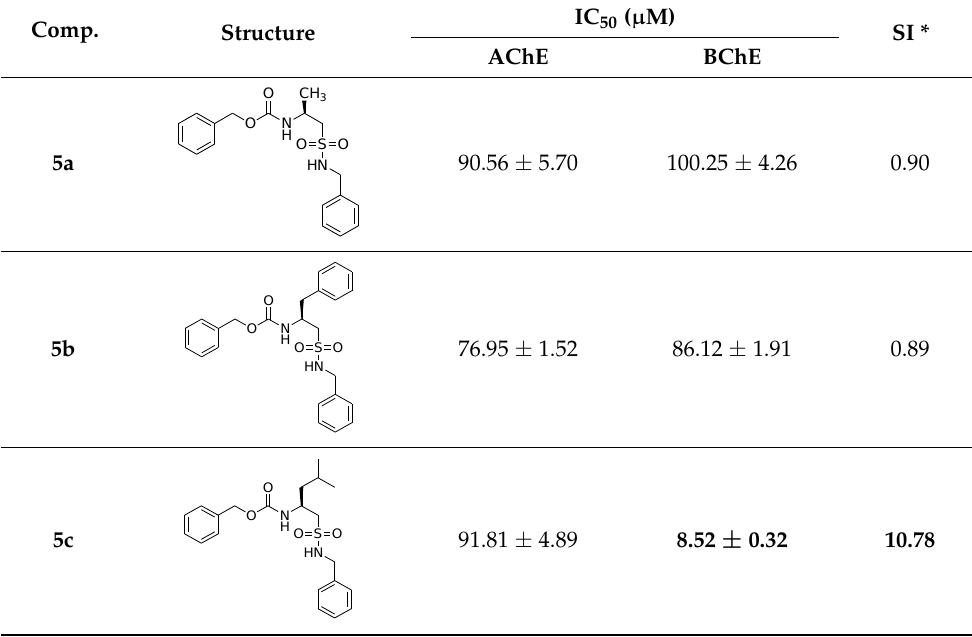
Table 1. Structures of discussed sulfonamides 5a–n and their in vitro AChE and BChE inhibition (IC 50 ( µ M)) compared with that of standard rivastigmine (RIV). Cholinesterase inhibition is expressed as the mean ± SD ( n = 3 experiments).